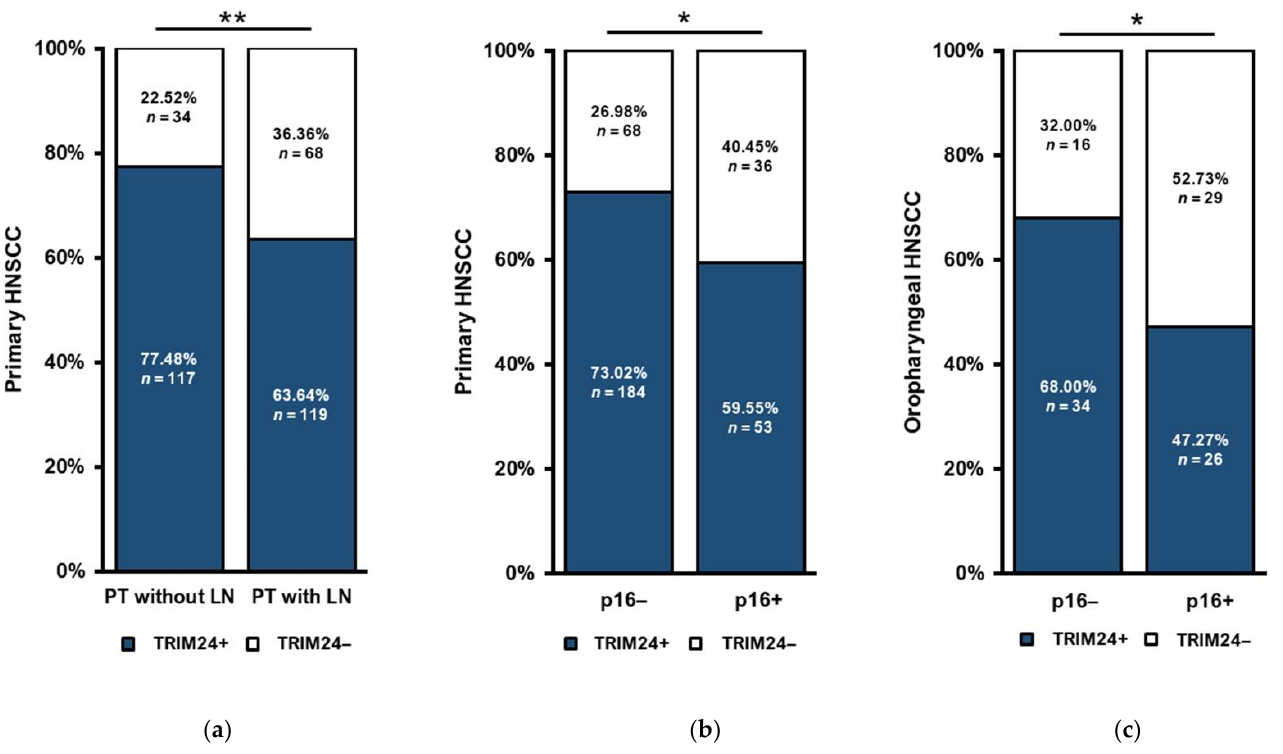
Figure 3. TRIM24 expression in PTs with different N-Stages. ( a ) HNSCC PTs without any LNs at the time of the first diagnosis were significantly more often TRIM24+ than PTs with LNs (Chi-square test, p = 0.006). (Chi-square test, p > 0.005). ( b ) We compared all HNSCC PTs by their p16 status and TRIM24 expression. P16 − PTs are significantly more often TRIM24+ than p16+ PTs (Chi-square test, p = 0.018). ( c ) We compared exclusively oropharyngeal HNSCC PTs by their p16 status and TRIM24 expression. P16 − PTs were also significantly more often TRIM24+ than p16+ PTs. (n.s. = not significant, * p ≤ 0.05, ** p ≤ 0.01).